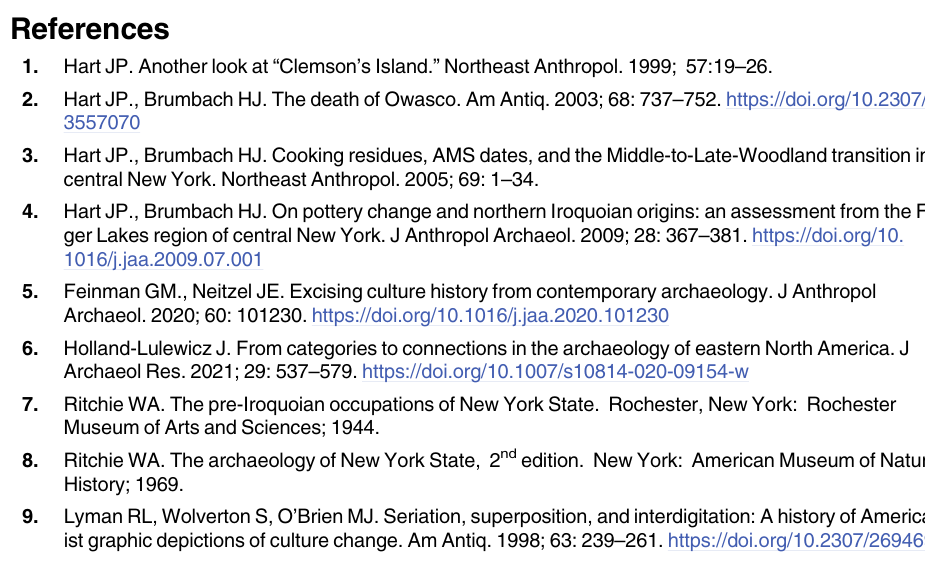
S1 Table. Radiocarbon dates used in the Bayesian analyses. S2 Table. Site order probability